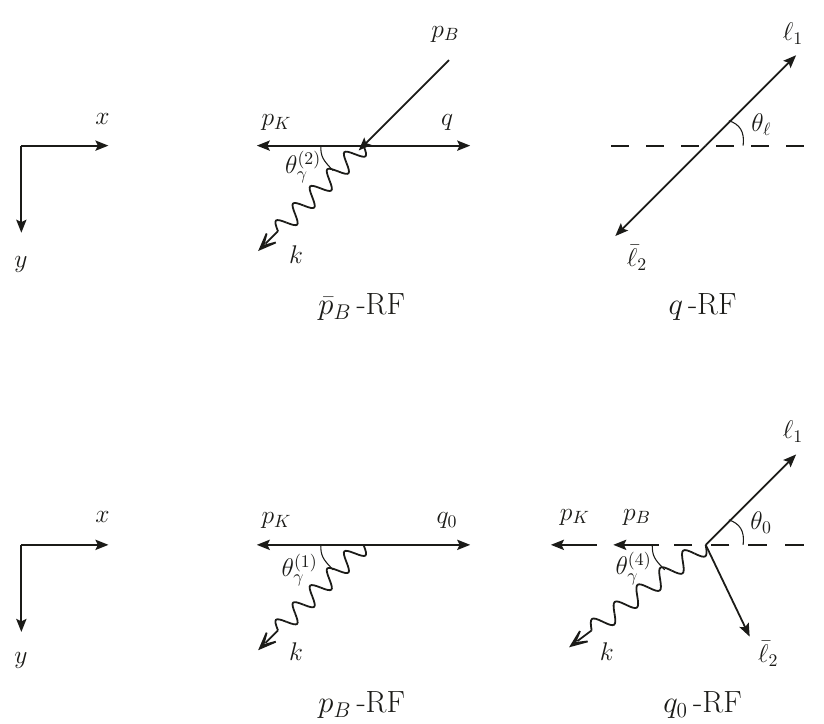
Figure 1 . Decay kinematics for the different RFs of interest. The dashed line corresponds to what is deferred to as the decay axis. For brevity we drop the frame-label on the lepton angles, θ ‘ ≡ θ (3) and θ 0 ≡ θ (4) , and if no frame-label is indicated on the photon angle, θ γ = θ (2) γ is usually 0